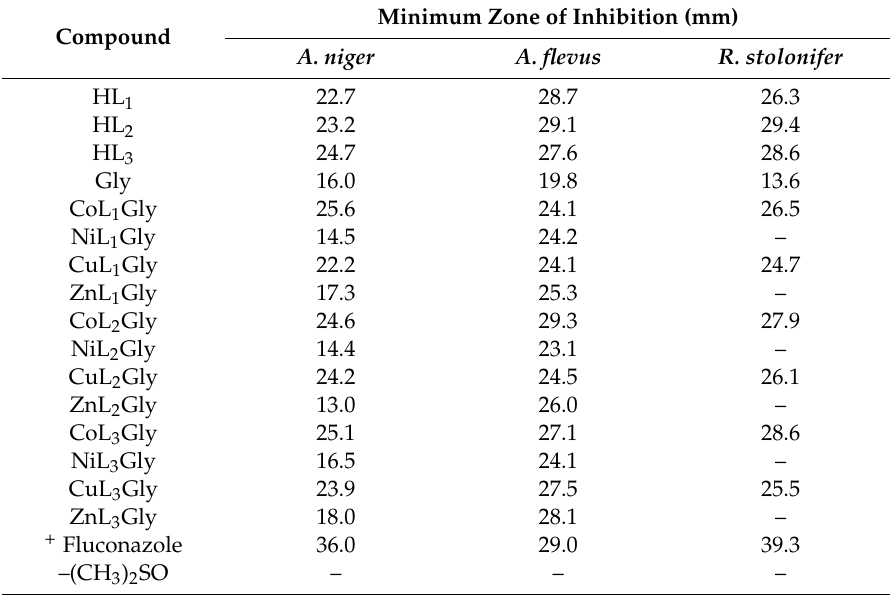
Table 4. Antifungal data of HL, Gly and Gly’s heteroleptic complexes at 1 mg/mL concentration .